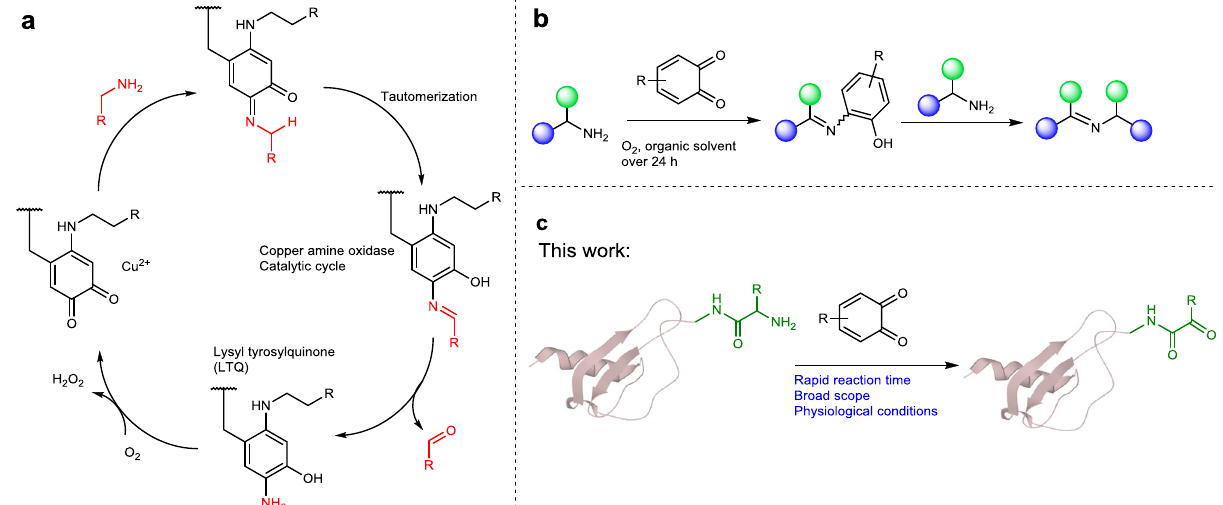
Fig. 1 Development of site-speci fi c N -terminal protein modi fi cation via quinone-mediated transamination. a Natural catalytic cycle of CuAOs; b Oxidation of primary amines with ortho -quinone to form imines; c Biomimetic quinone-mediated transamination inspired by CuAOs. the quinones may be suitable reagents for the selective and ef fi cient oxidation of the N -terminal α -amines of proteins to aldehyde or ketone with fast kinetics as well as a wide scope of amino